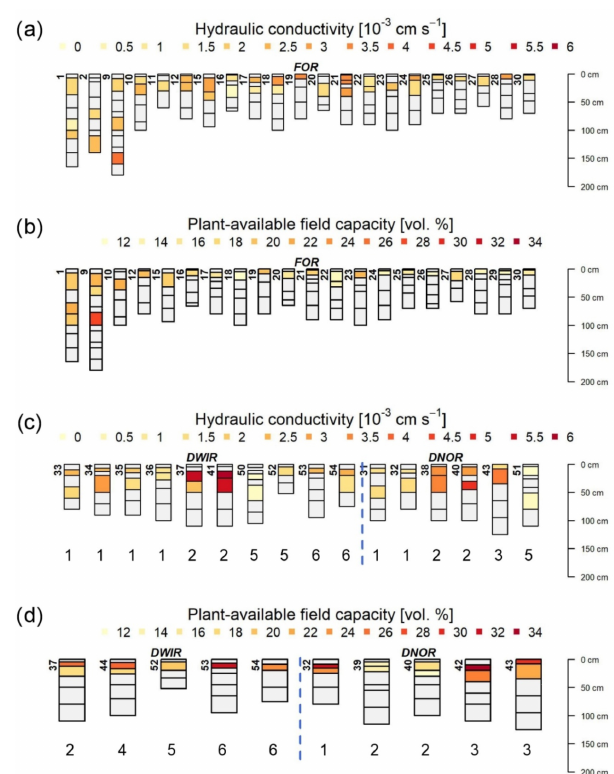
Figure 7. Hydraulic conductivities (a) and plant-available field ca- pacities (b) of soils under near-natural forest (FOR) and hydraulic conductivities (c) and plant-available field capacities (d) of soils un- der disturbed forest with regrowth of trees (DWIR; left) and under disturbed forest showing no regrowth of trees (DNOR; right). Soil horizons in light grey were not subjected to these measurements. The same numbers under the profiles in panels (c) and (d) indicate that the profiles were located at the same